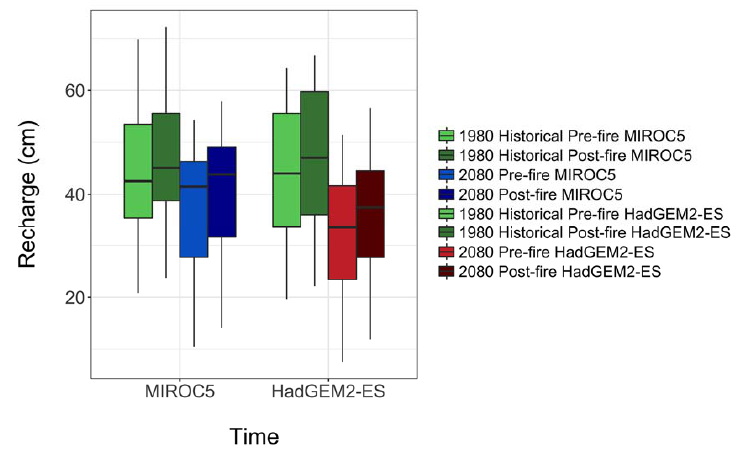
Figure 8. Potential mean basin recharge for MIROC5 in RCP 4.5 and HadGEM2-ES in RCP 8.5 before and after forest cover reduction in comparison to historic conditions.